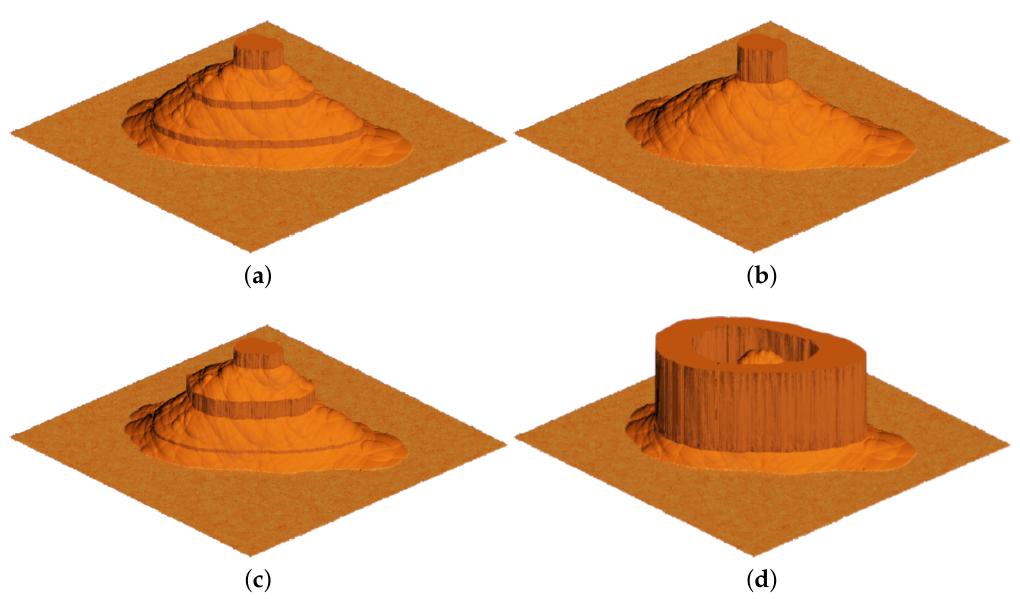
Figure 18. Comparison of the impact of material hardness selection on the model geometry. The model consisted of 5 materials. Hardness values are given in the following order: ( a ) 0.0; 0.25; 0.5; 0.75; 1.0. ( b ) 0.0; 0.25; 0.25; 0.25; 1.0. ( c ) 0.1; 0.2; 0.3; 0.9; 1.0. ( d ) 0.0; 0.25; 1.0; 0.5;